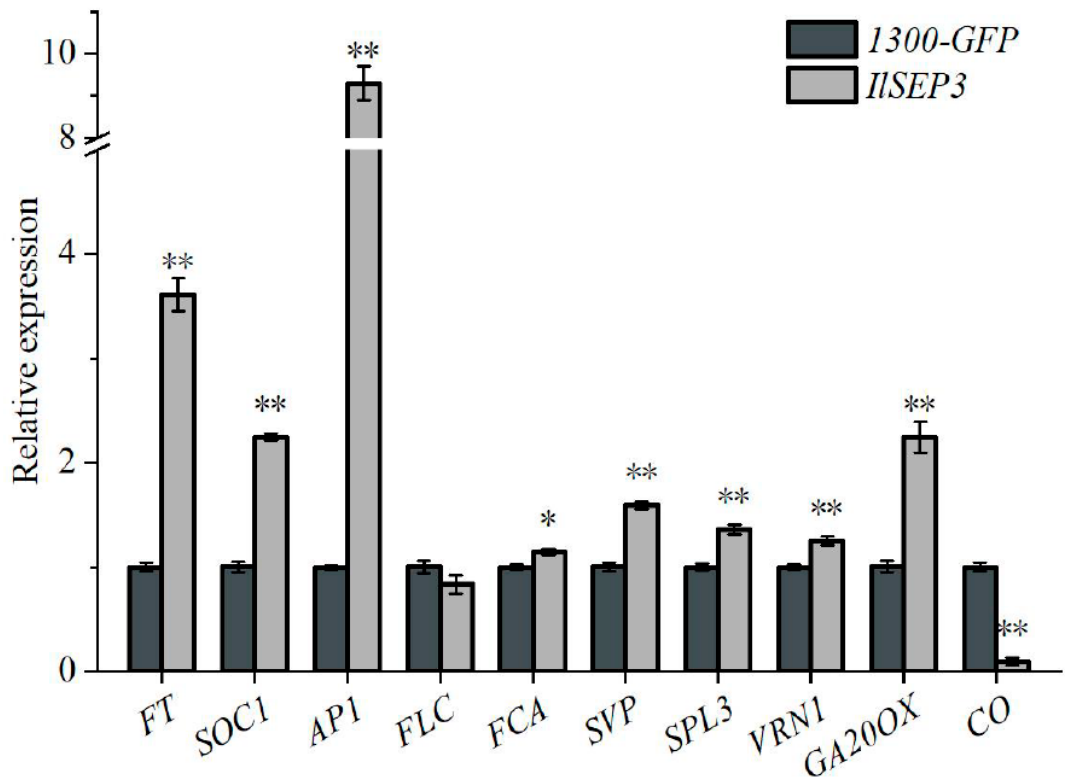
Figure 7. Expression of endogenous flowering time genes in transgenic Arabidopsis overexpressing IlSEP3 . Data represent mean ± standard error. Statistical difference was denoted by * ( p < 0.05) or ** ( p < 0.01).